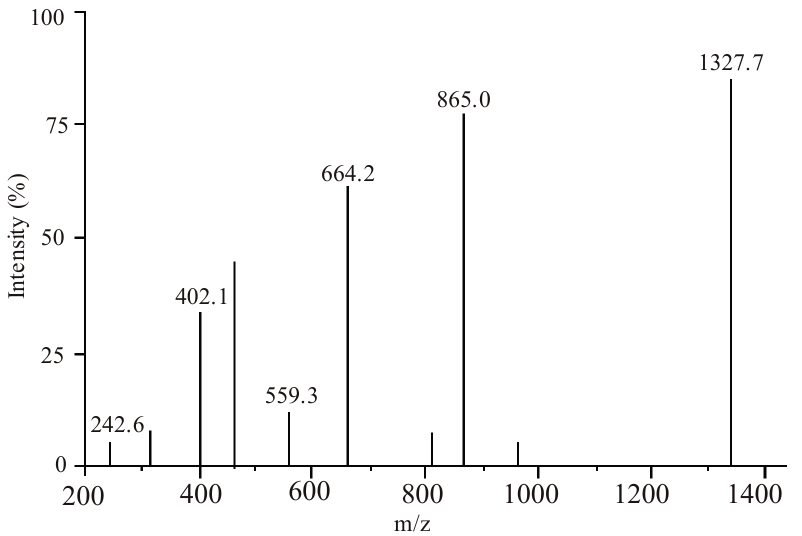
Figure 11. ESI-MS spectrum of Cu-moxifloxacin solution at pH =